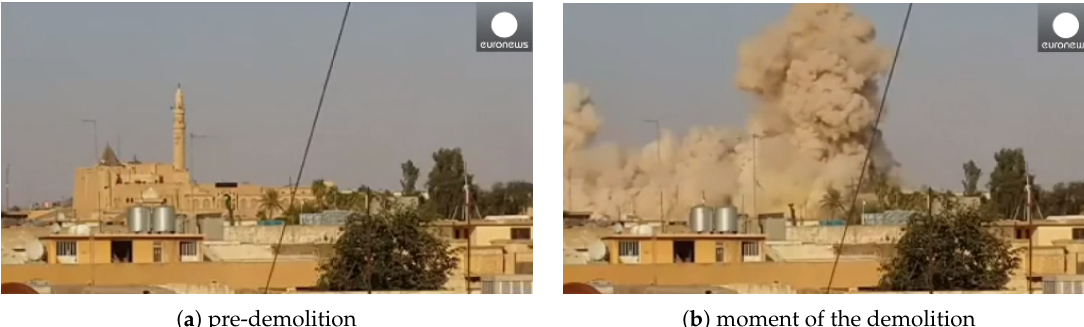
Figure 16. Destruction of Nebi Yunus Mosque—two frames of the video released by ISIL in late July 2014 [27].